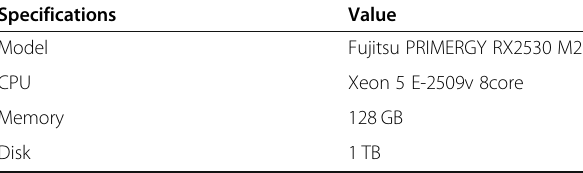
Table 3 Hardware specifications of central cloud servers